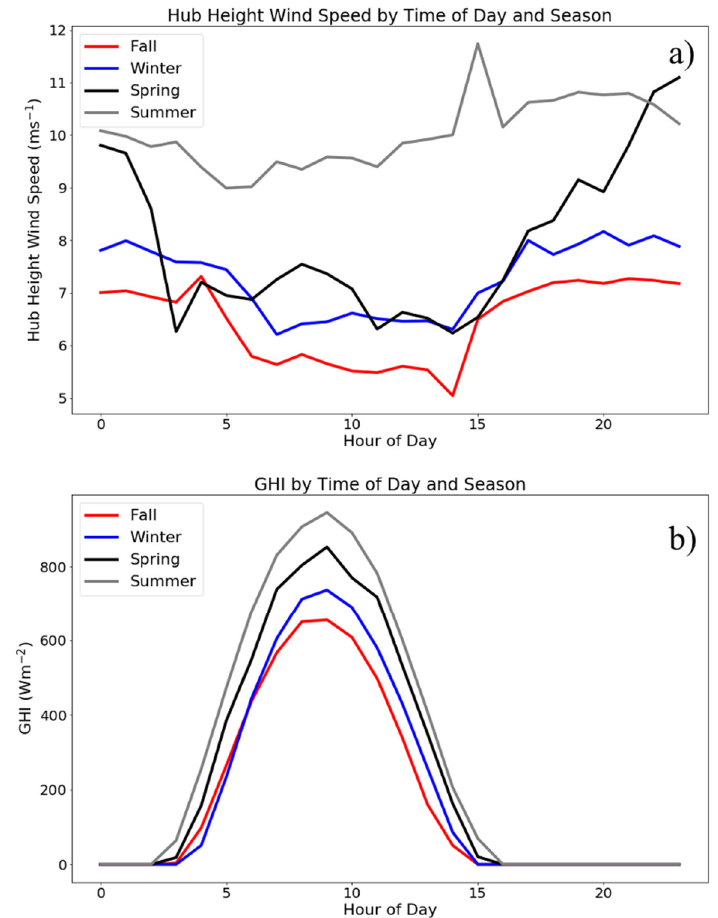
Figure 1. Plot of the average hub-height wind speed by hour of the day (UTC) and by season from 21 Dec 2017 through to 20 Dec 2018 ( a ) and global horizontal irradiance (GHI) by hour of the day and by season ( b ).